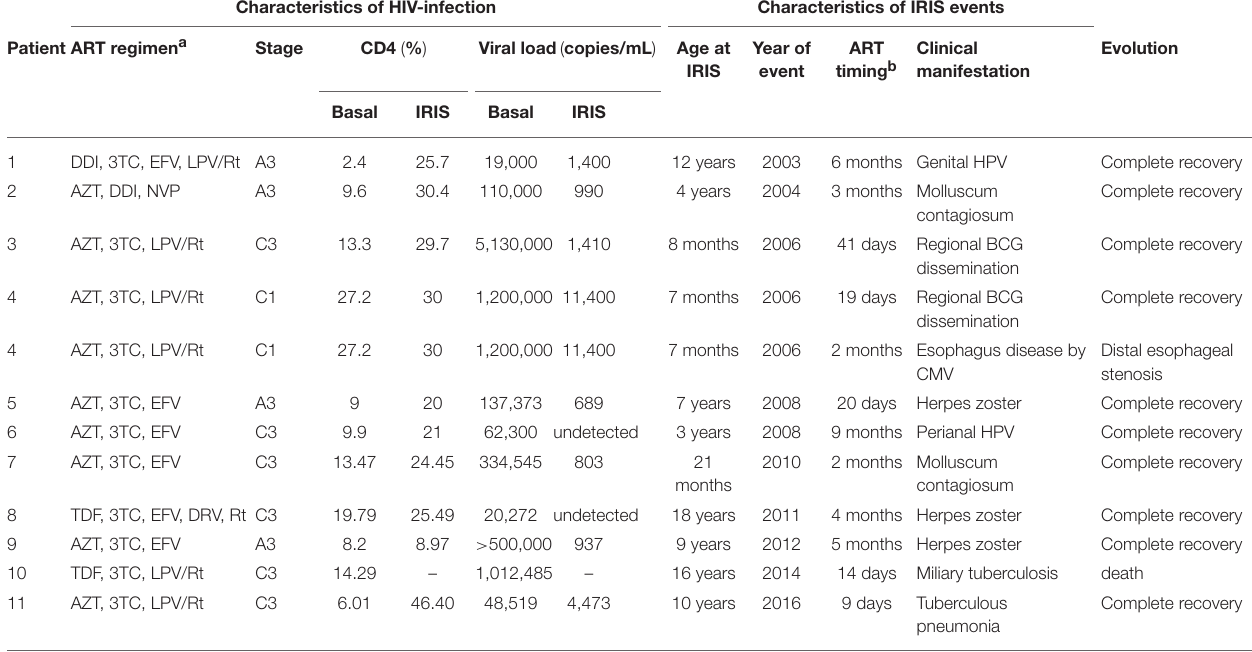
TABLE 1 | Characteristics of clinical manifestations and staging, laboratory findings, therapeutic approach, and evolution of female patients with IRIS. Characteristics of HIV-infection Characteristics of IRIS